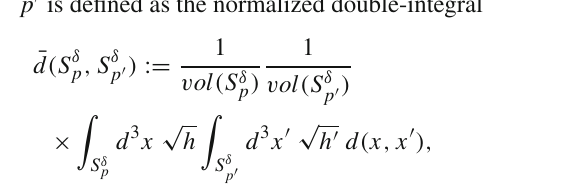
of radius δ , p (cid:4)